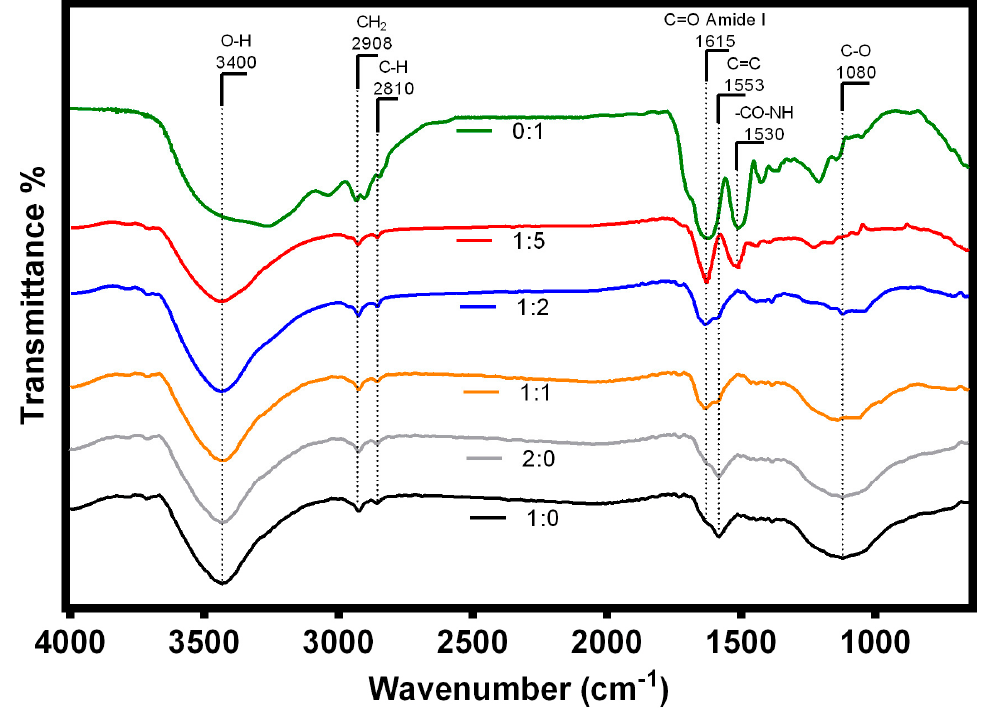
Figure 4. FTIR spectra of hybrid composites with different compositions of activated carbon (AC) and whey fibrils (WF) with respect to whey fibrils alone (green line) and pure activated carbon (black line).